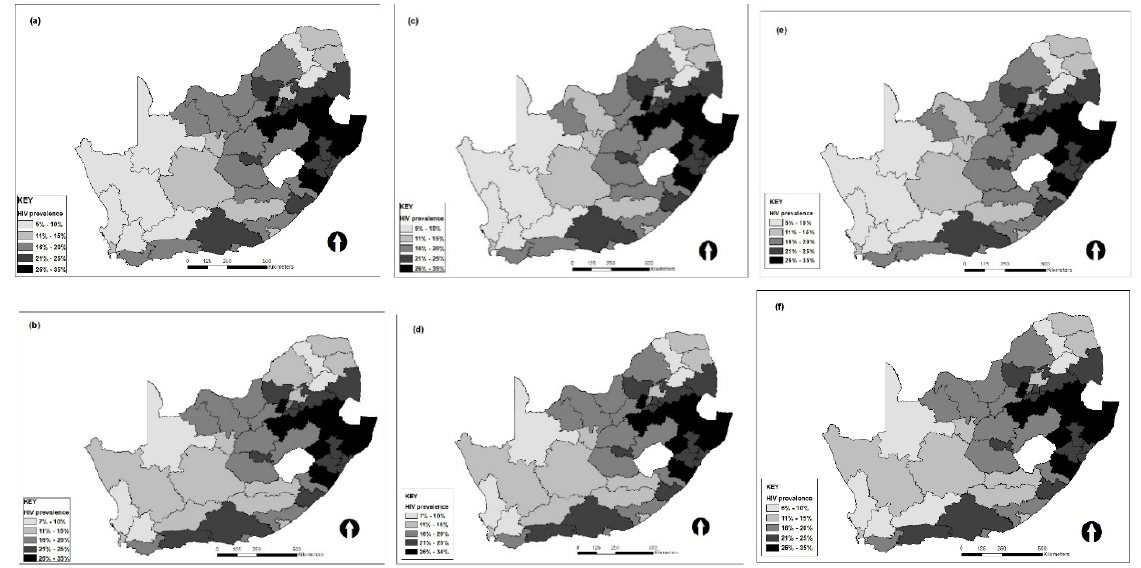
Figure 2. Estimated HIV prevalence by district in South Africa with covariates (first row a , c , e ) and without covariates (second row b , d , f ).